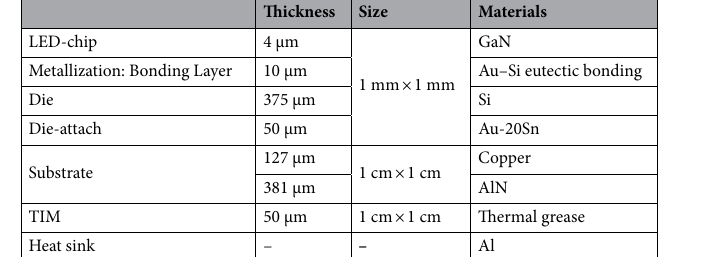
Table 1. Properties of dimensions and materials of LED package 8